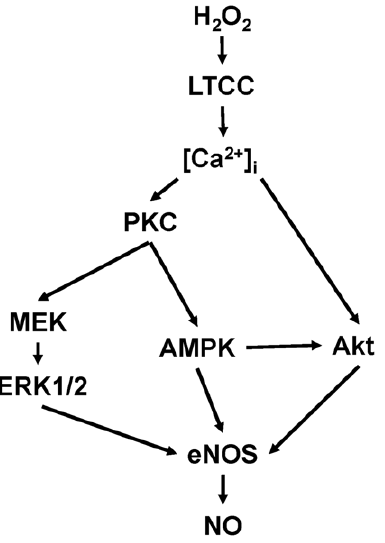
Figure 8. Scheme for H 2 O 2 -mediated regulation of eNOS signaling in cardiac myocytes. In this model, H 2 O 2 activates the L-type Ca 2 + channel (LTCC), causing an elevation in [Ca 2 + ] i . The increase in [Ca 2 + ] i promotes phosphorylation and activation of protein kinases PKC and Akt, which lead to an increase in eNOS phosphorylation. Activation of PKC is required for the phosphorylation of MEK1/2, ERK1/ 2, and AMPK, which in turn promote eNOS phosphorylation and an increase in NO synthesis. See the text for additional